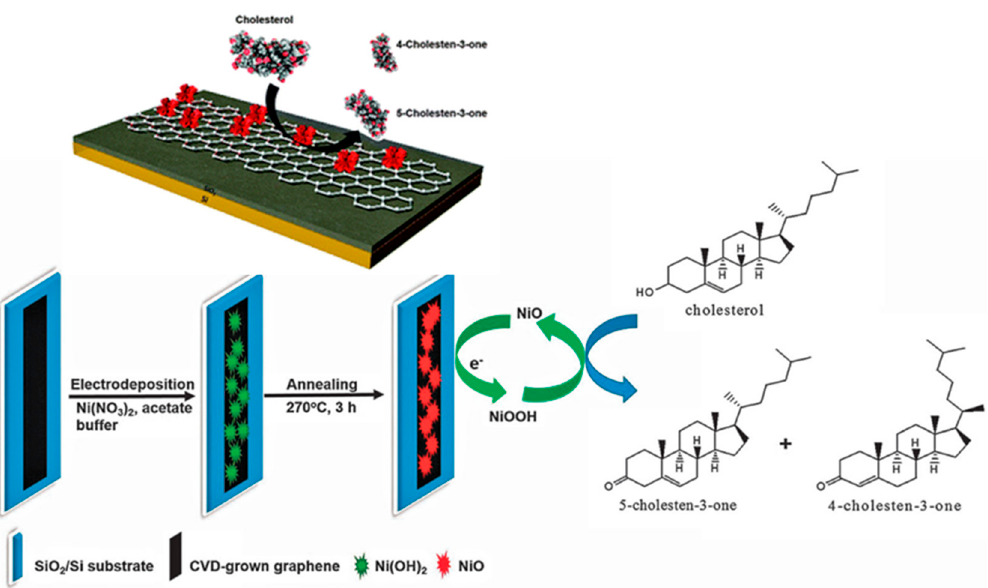
Figure 9. Schematic illustration of the fabrication of the NiO/graphene composite electrode for cholesterol sensing. Reprinted with permission from Ref. [76].